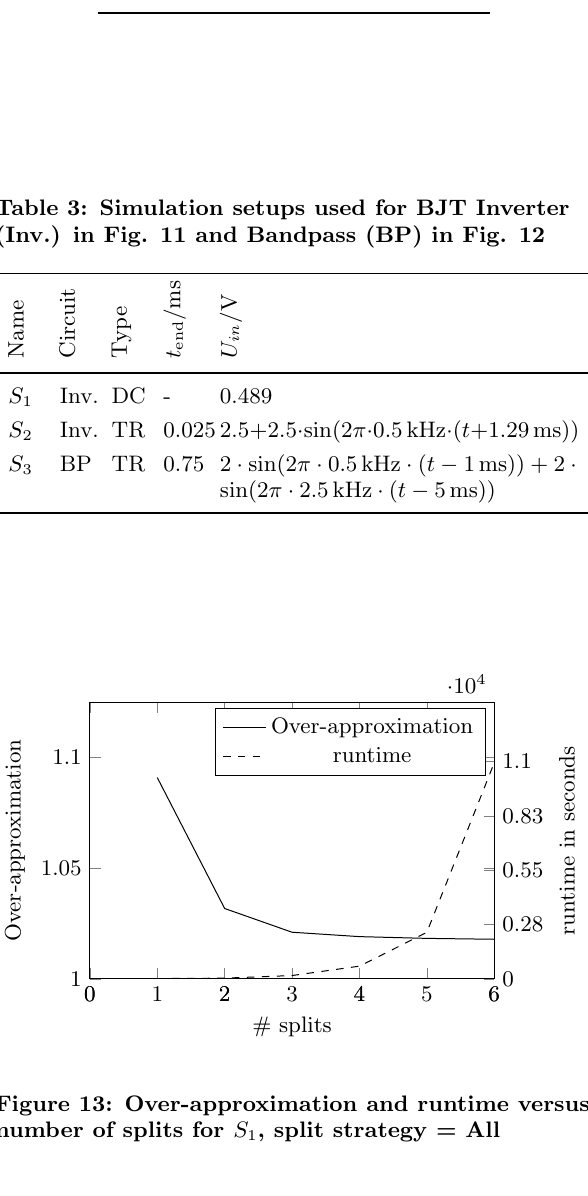
Figure 12: Bandpass circuit